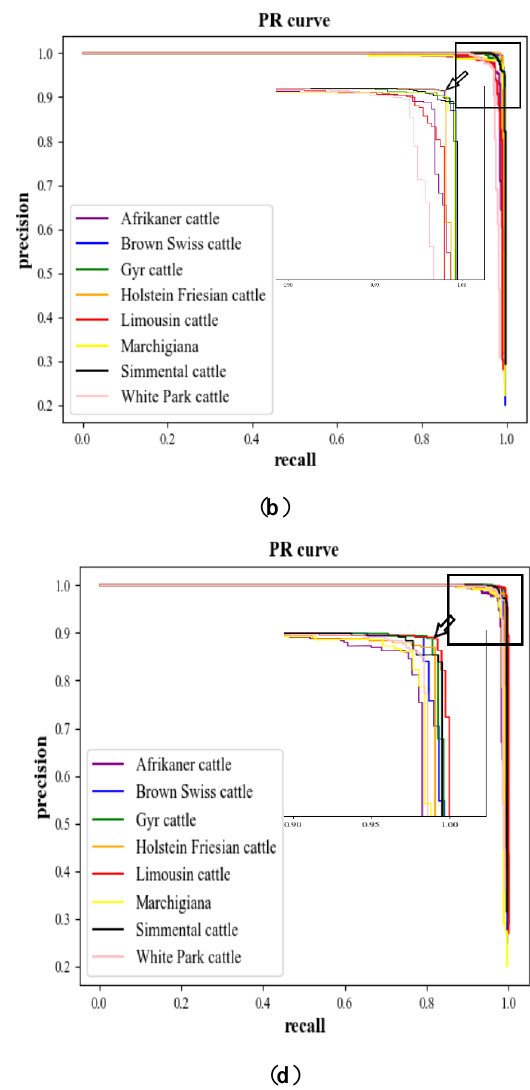
416, 0.75 ( c ) 608 × 608, 0.50 ( d ) 608 × 608, 0.75. 0.75 ( c ) 608 × 608, 0.50 ( d ) 608 × 608,